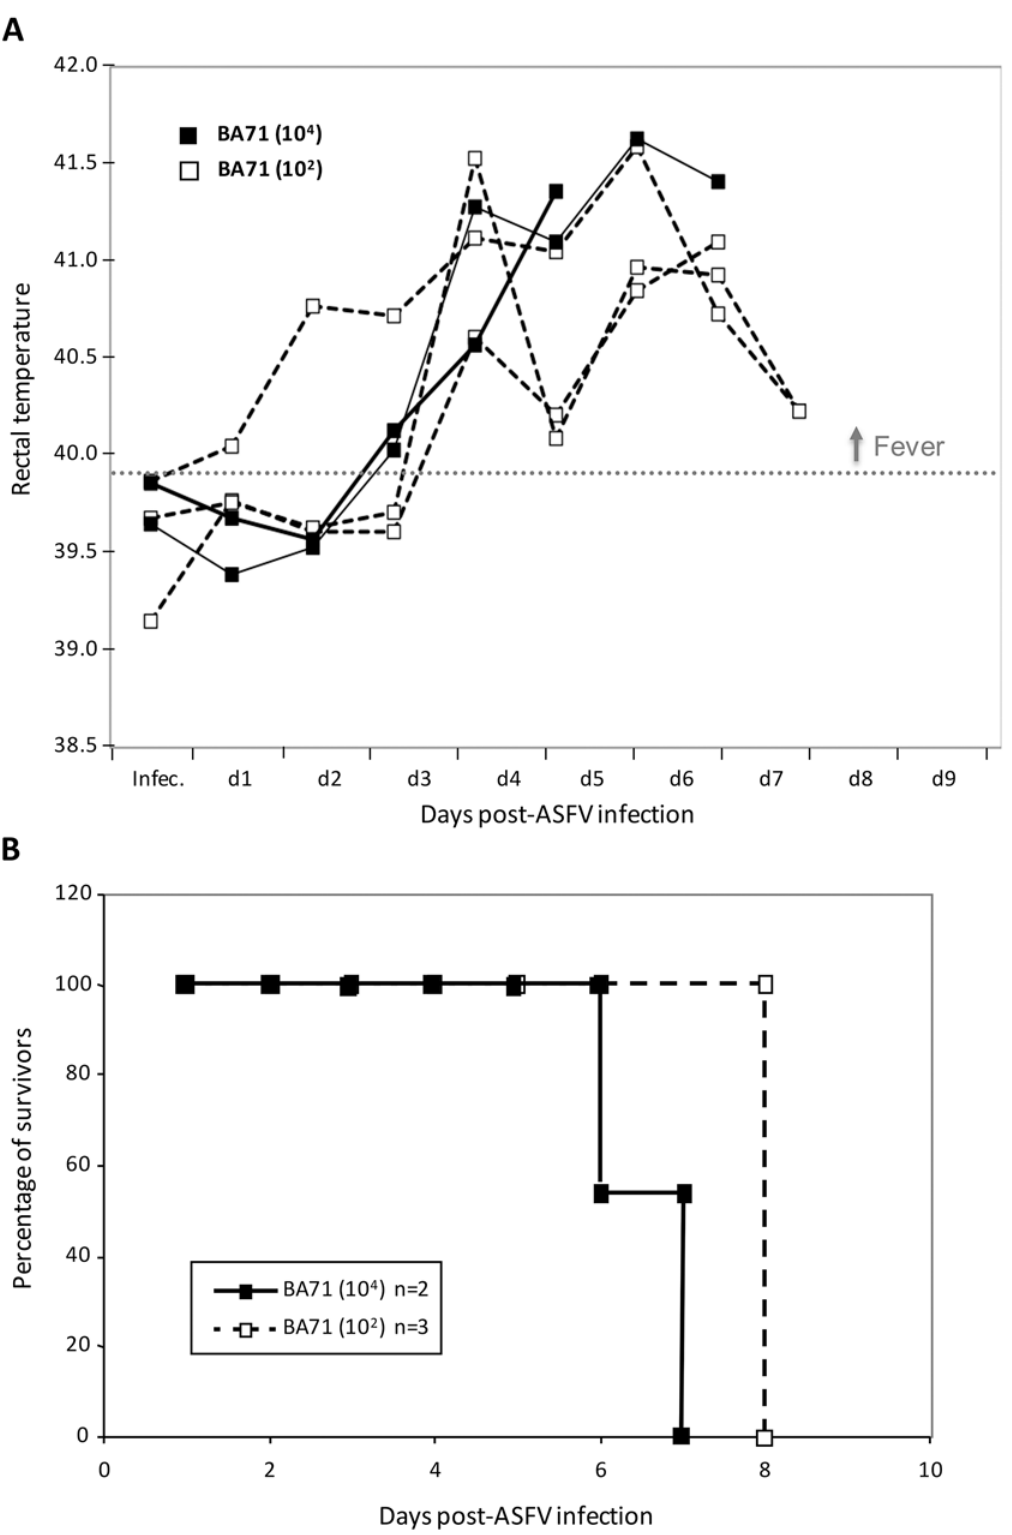
Fig 1. Virulence of ASFV BA71 strain. (A) Rectal temperatures were daily recorded after infection of pigs with 10 2 or 10 4 HAU50 of BA71. (B) Survival of pigs after infection with 10 2 or 10 4 HAU50 of BA71. doi:10.1371/journal.pone.0142889.g001 PLOS ONE | DOI:10.1371/journal.pone.0142889 November 30,